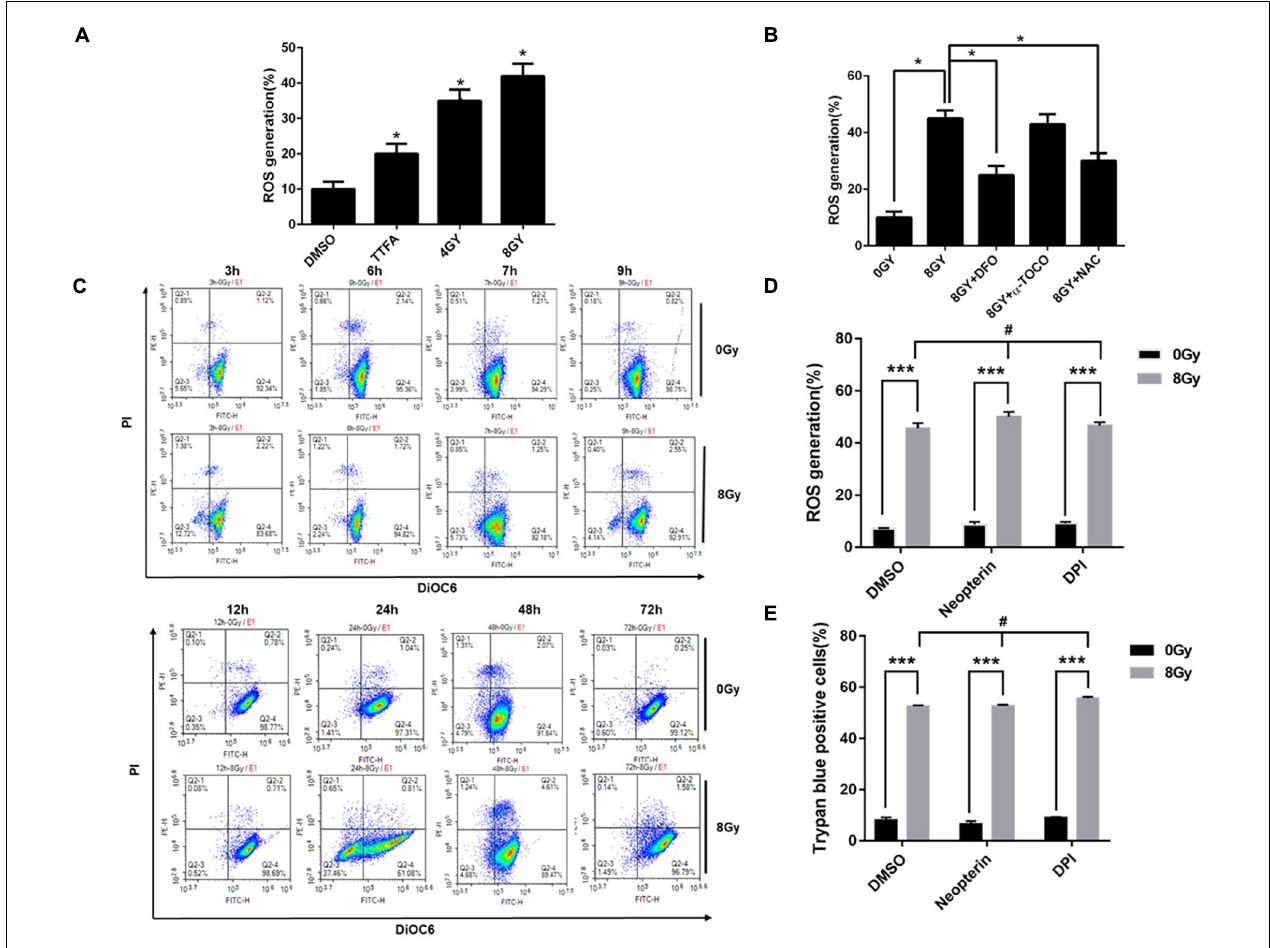
FIGURE 5 | Radiation-induced ROS generation is due in part to iron in MDA-MB-231 breast cancer cells. Radiation-induced ROS was determined in MDA-MB-231 cells, TTFA (Hypochondria Complex II inhibitor) was used as a positive control (A) . The effects of DFO (0.1 mM), NAC (10 mM), and a -tocopherol (2 µ M) on radiation-induced ROS in MDA-MB-231 cells was determined (B) . The mitochondrial transmembrane potential ( (cid:49)(cid:57) m) was detected with DIOC6(3)/PI and analyzed by flow cytometry (C) . Cells were pretreated with Neopterin (50 nM), DPI (5 µ M) for 1 h before 8 Gy radiation, the amount of ROS generation and cell death was determined (D,E) . These results were representative of three independent experiments and expressed as means ± SD. P -values were calculated using repeated measure ANOVA with P < 0.05 being considered as statistical significance, * P < 0.05, *** P < 0.001, # P >